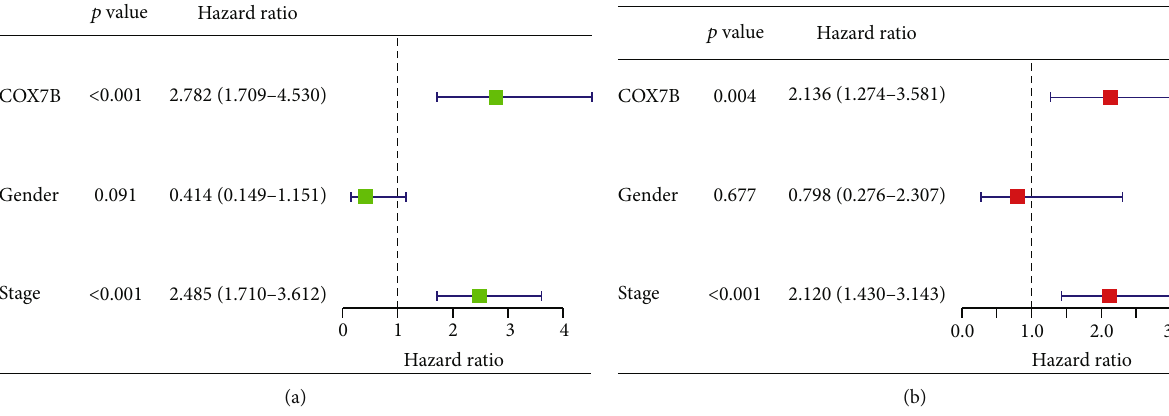
Figure 4: Univariate (a) and multivariate (b) analyses of prognostic factors in ESCA